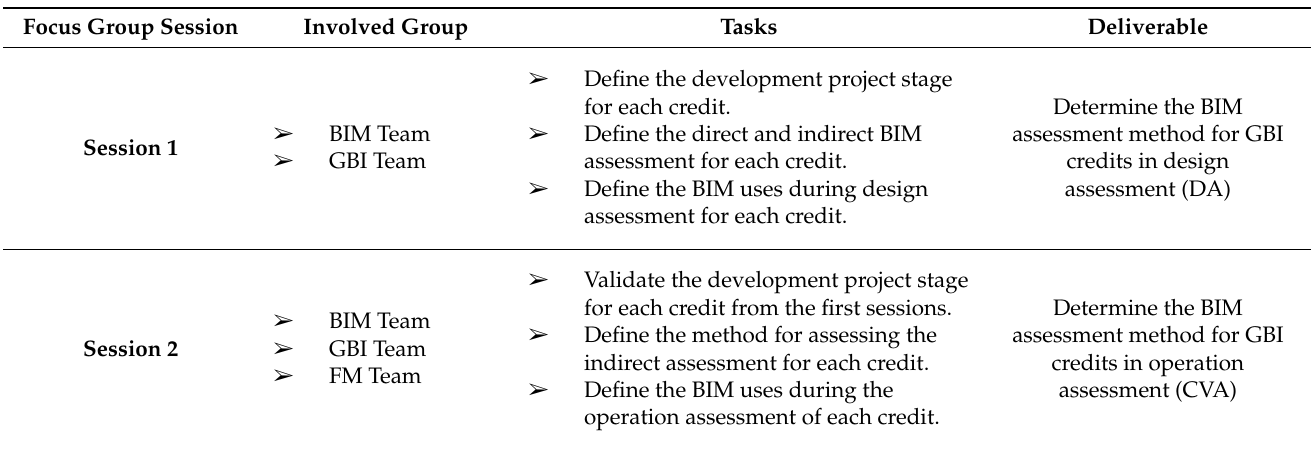
Table 1. The Focus Group Session.